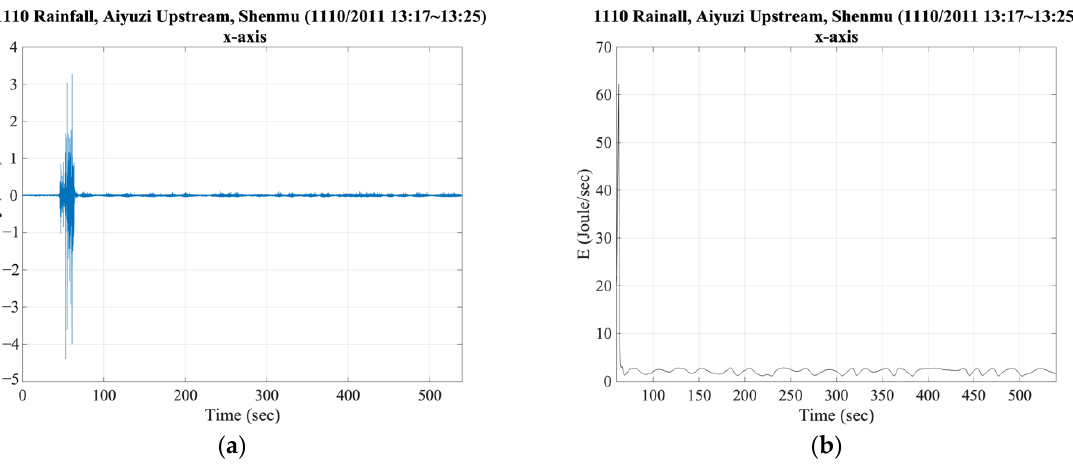
Figure 4. The data of 1110 Rainfall in 2011 ( a ) vibration signals ( b ) accumulated energy per second.